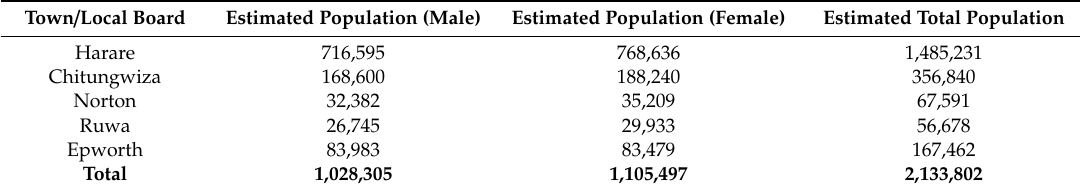
Table 1. Population figures for the study area